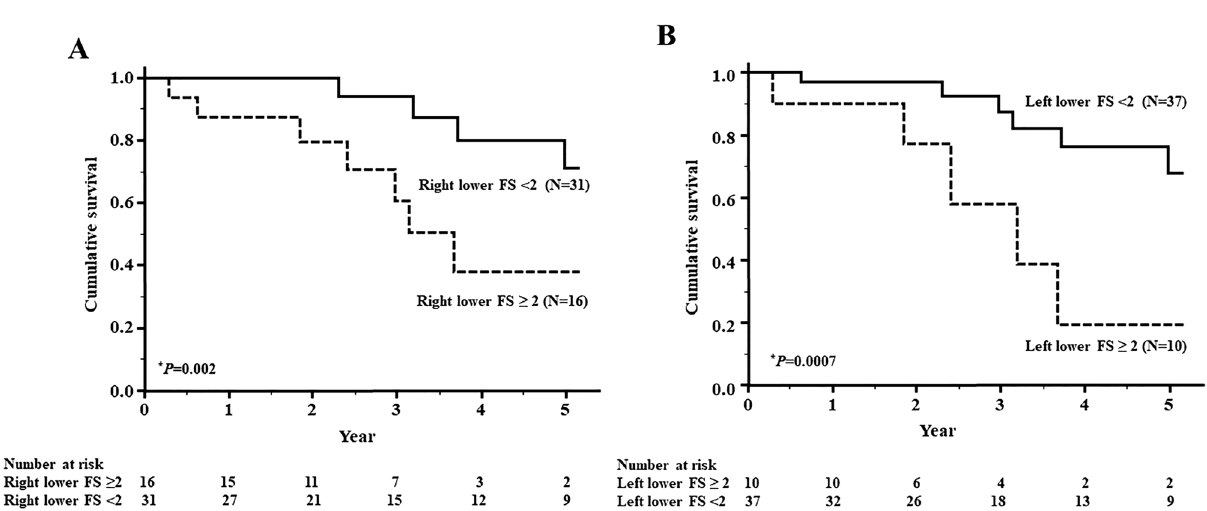
Figure 4. Survival curves of patients with microscopic polyangiitis (MPA)-interstitial lung disease (ILD) based on their right or left lower lobe fibrosis score. ( A ) The 5-year survival rate was significantly lower in the patients with a right lower lobe fibrosis score ≥ 2 (37%) than in those with a score < 2 (71%) ( P = 0.002). Solid line: < 2, dashed line: ≥ 2. ( B ) The 5-year survival rate was significantly lower in the patients with a left lower lobe fibrosis score ≥ 2 (19.3%) than in those with a score < 2 (68%) ( P = 0.0007). Solid line: < 2, dashed line: ≥ 2. Survival rates were calculated by the Kaplan–Meier method and compared by log-rank test. * P <